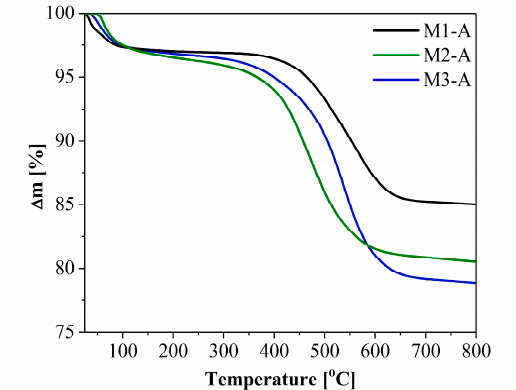
Figure 3. Thermogravimetric (TG) curves of the functionalized silica monoliths.